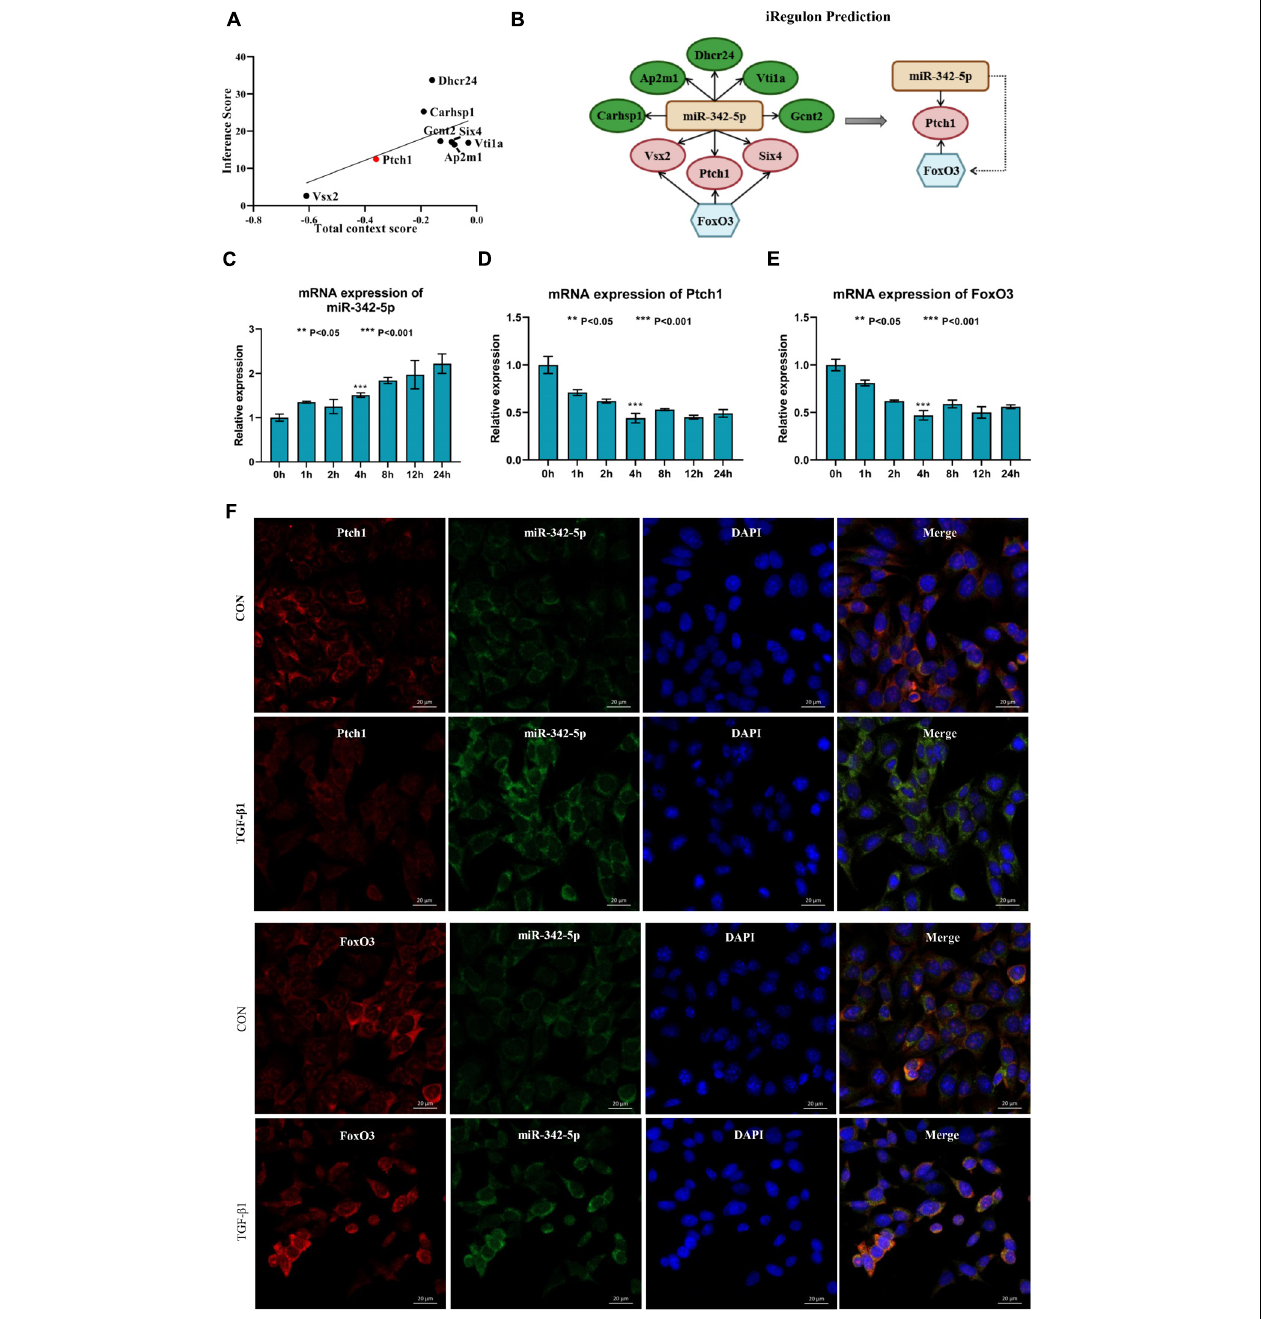
FIGURE 5 | Ptch1 is the most promising target mRNA of miR-342-5p. (A) Regression analysis showing Ptch1 as the most promising target mRNA of miR-342-5p. (B) The iRegulon prediction showing FoxO3 as potential transcription factor of Ptch1. (C–E) Real-time PCR showing that TGF- β 1 increases miR-342-5p and decreases FoxO3 and Ptch1 in TCMK-1 cells. (F) FISH experiments showing that miR-342-5p is mainly distributed in the cytoplasm of TCMK-1 cells, as is FoxO3 and Ptch1. The merged images show that miR-342-5p is partially colocalized with FoxO3 and Ptch1.